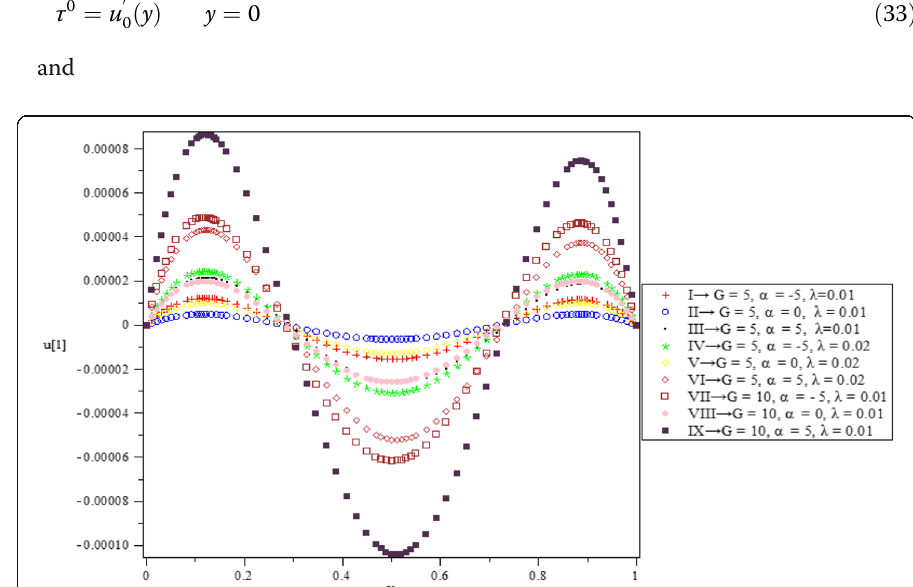
Fig. 12 First-order velocity (u[1] profile, r = − 1, ϵ = 0.25, P = 7, and β =